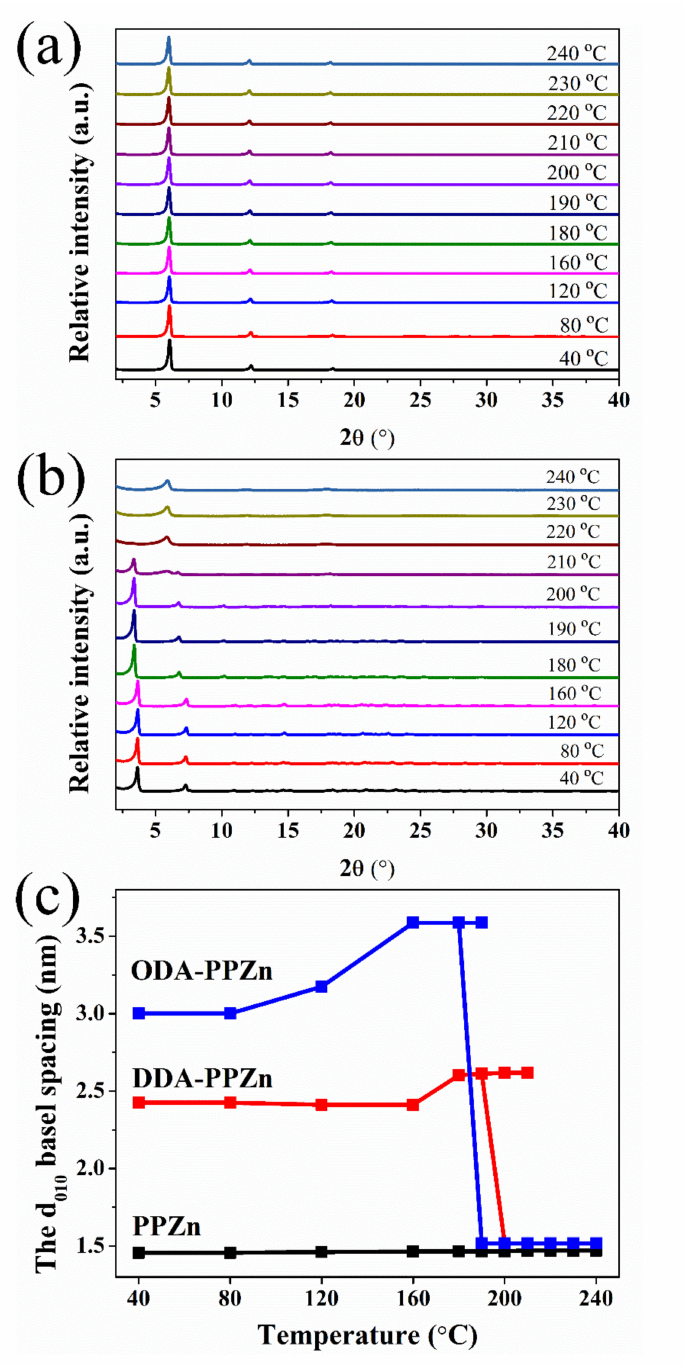
Figure 3. In situ wide-angle x-ray di ff raction (WAXD) patterns of ( a ) PPZn and ( b ) DDA-PPZn in the temperature range of 40–240 ◦ C. ( c ) The relationship between the d010 basal spacing and temperature of PPZn, DDA-PPZn, and